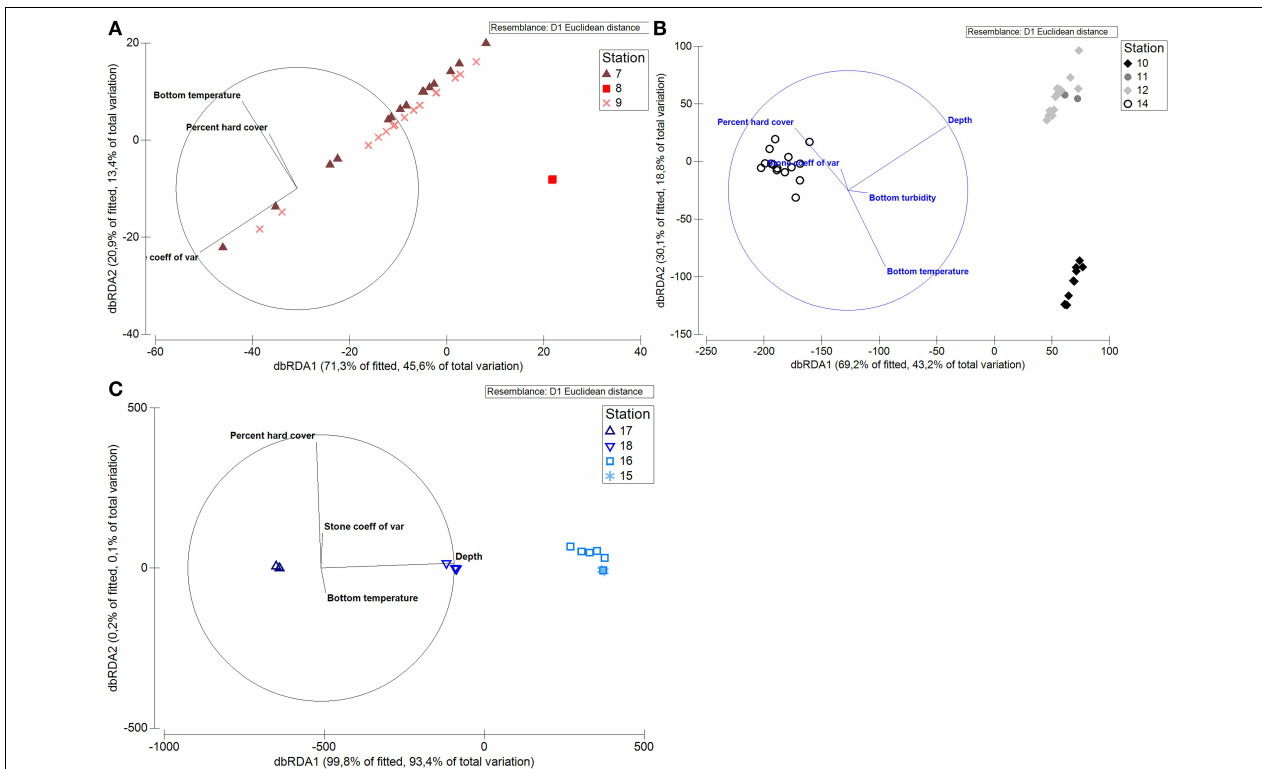
FIGURE 12 | dbRDA graph showing relationship of functional traits of north Svalbard fauna to abiotic factors. (A) Stations in Raudfjorden, (B) stations on north Svalbard shelf, (C) stations in Rijpfjorden.